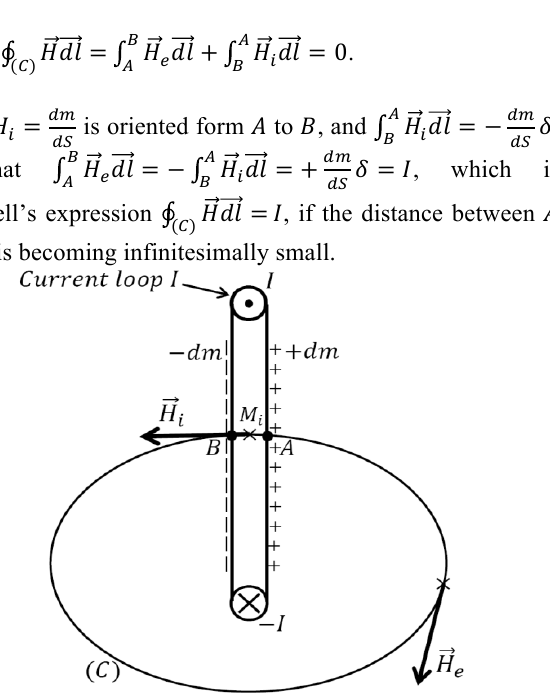
Figure APPENDIX 3: Equivalence between Ampere’s and Maxwell’s expressions of the Ampere’s